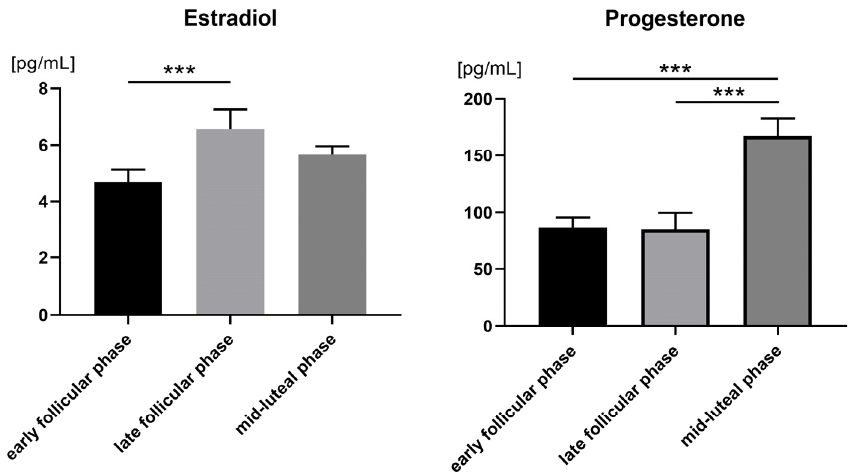
Figure 3. Levels of estradiol and progesterone in saliva, across the menstrual cycle. Error bars represent the standard error of the mean. *** p < 0.001.